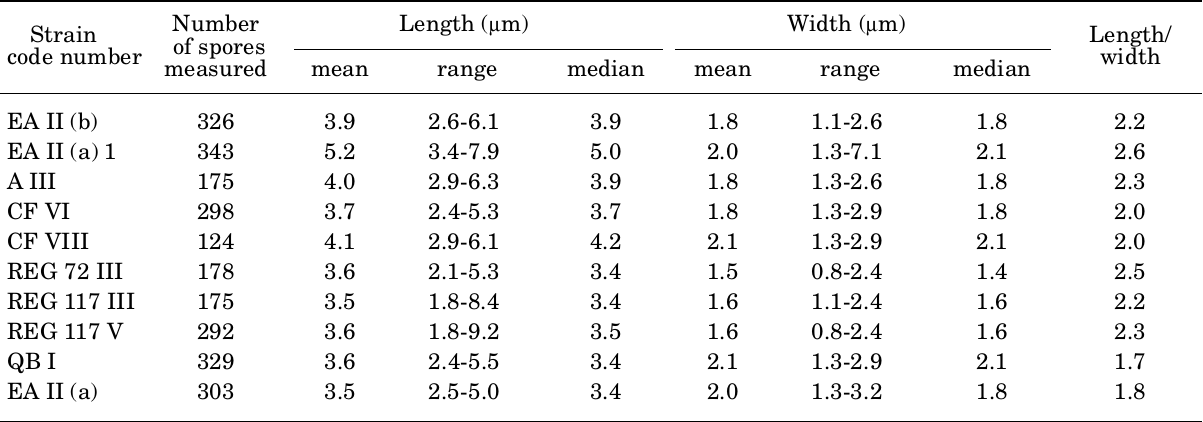
Table 3. Dimension of conidia in Phaeoacremonium chlamydosporum and P. angustius strains.